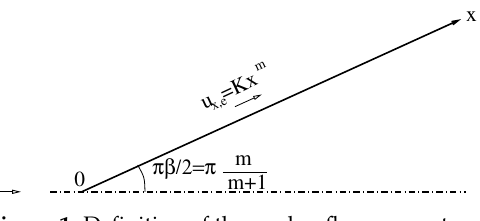
Figure 1. Definition of the wedge-flow